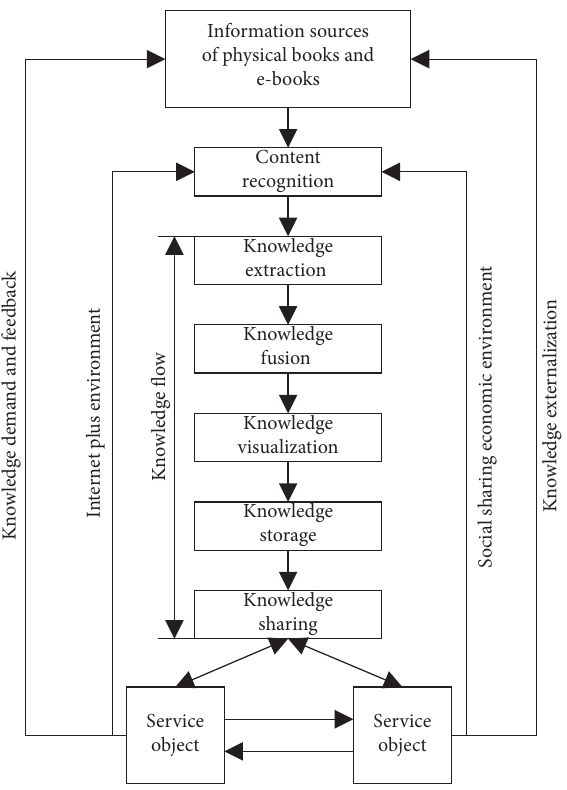
Figure 2: Structure of knowledge sharing service